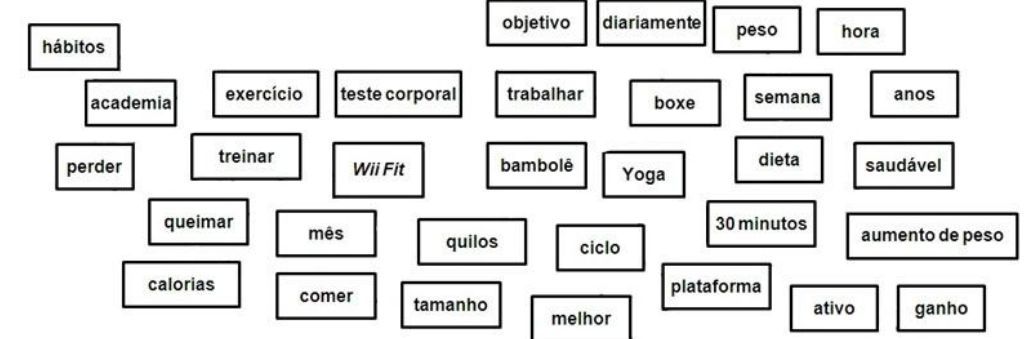
Figura 2. Conceitos mais frequentes nas